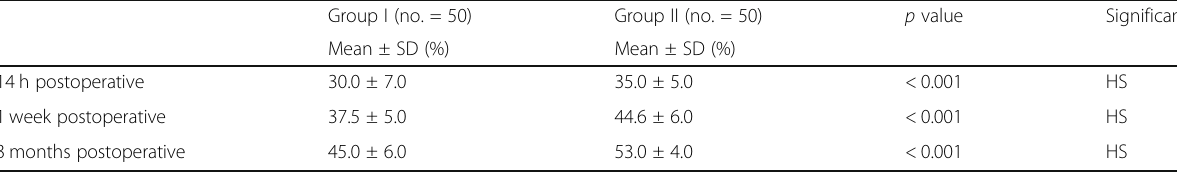
Table 6 Postoperative left ventricular ejection fraction (%) Group I (no. = 50) Group II (no. =